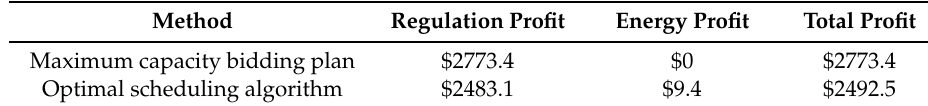
Table 1. Frequency regulation scheduling